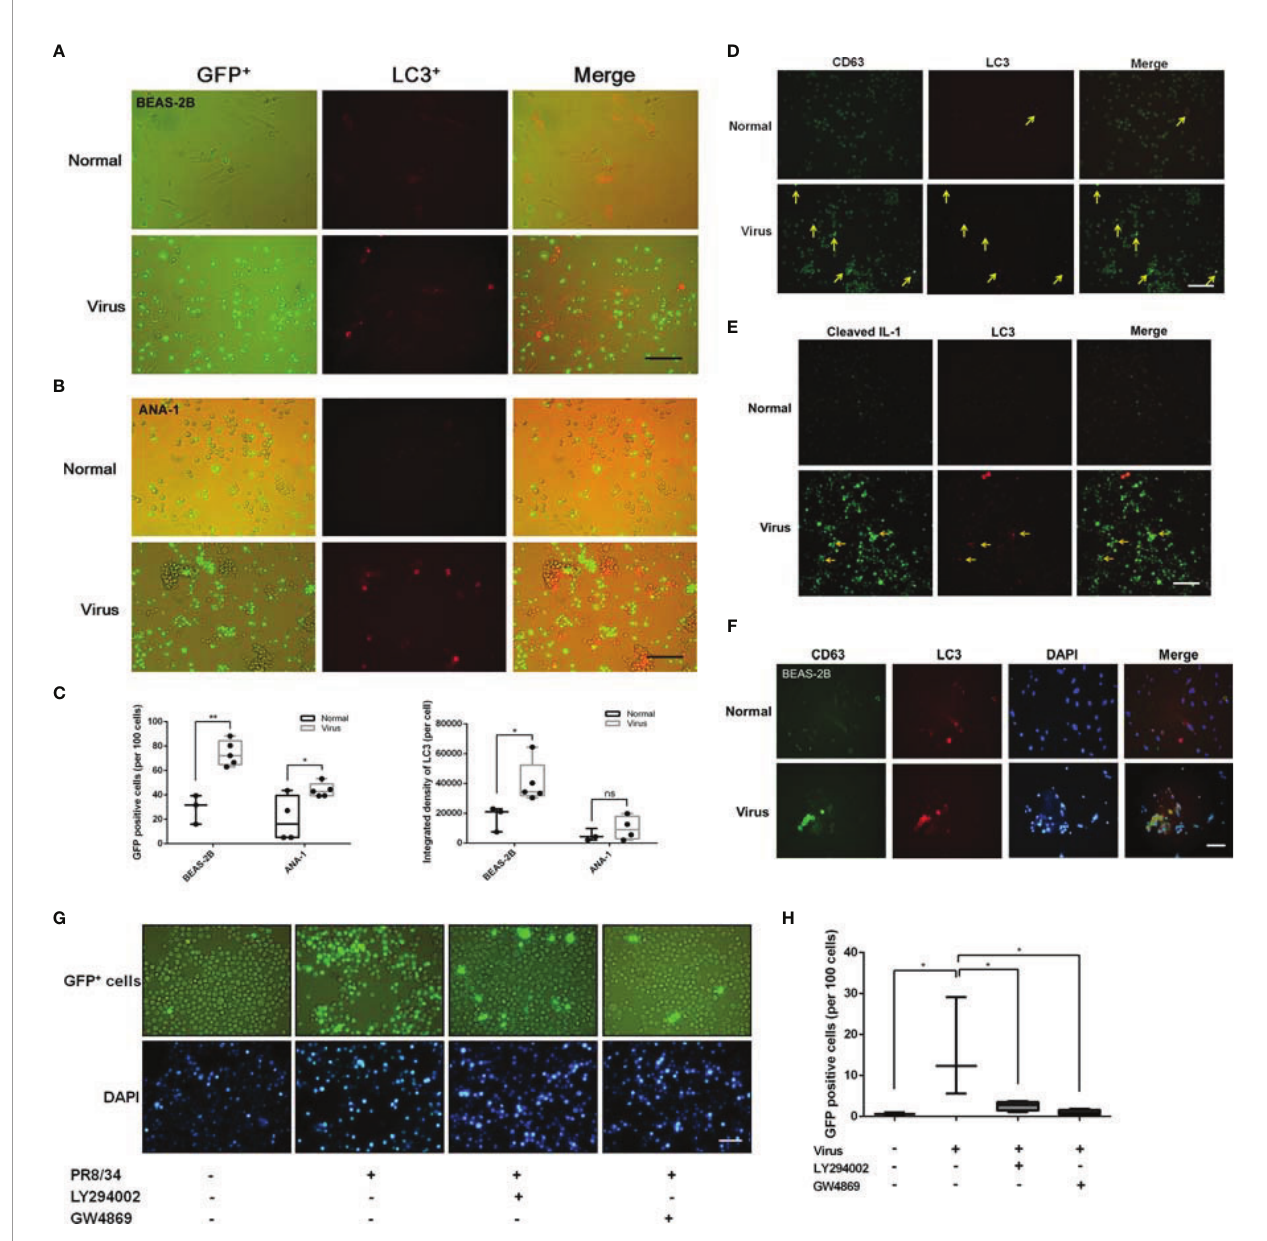
FIGURE 6 | Crosstalk among LC3, CD63, and cleaved IL-1 b in macrophage recruitment. (A, B) Transwell assays results showed that LC3 enhanced macrophage recruitment in PR/8/34 infected BEAS-2B cells (A) and ANA-1 cells (B) . GFP + ANA-1 cells were incubated in the upper chambers, BEAS-2B and ANA-1 cells transfected with mRFP-LC3 lentivirus were incubated in the lower chambers and infected with PR/8/34 virus. Scale bar: 100 m m. (C) Cell counting of GFP-positive cells (per 100 cells) and the fl uorescent quantitation of LC3 (per cell) using the Image-Pro Plus 6.0 software. No fewer than three fl uorescent images were captured and analyzed per group. * p < 0.05 and ** p < 0.01. (D, E) LC3, CD63, and IL-1 b interaction. The ANA-1 cells transfected with mRFP-LC3 lentivirus were infected with PR/8/34 virus for 24 h. Then, these cells were fi xed, permeabilized, blocked, probed with primary antibodies for the detection of CD63 (D) , and cleaved IL-1 b (E) , followed by exposure to the anti-rabbit IgG Fab2 Alexa Fluor ® 488 molecular probes. After staining the cell nuclei with DAPI, the interaction between LC3/ CD63/IL-1 b was observed and imaged. Scale bar: 100 m m. (F) LC3 and CD63 interaction in the infected BEAS-2B cells. The BEAS-2B cells transfected with mRFP- LC3 lentivirus were infected with PR/8/34 virus for 24 h. The cells were then fi xed, permeabilized, blocked, and probed with primary antibodies for the detection of CD63, followed by the anti-rabbit IgG Fab2 Alexa Fluor ® 488 molecular probes. After staining the cell nuclei with DAPI, the interaction of LC3/CD63 was observed and imaged. Scale bar: 50 m m. (G) The in fl uence of autophagy and exosome inhibitors on macrophage recruitment. GFP + ANA-1 cells were incubated in the upper chambers of the transwell system, while ANA-1 cells were incubated in the lower chambers, infected with PR/8/34 virus, and treated with the autophagy inhibitor LY294002 (1 µM) and the exosome inhibitor GW4869 (1 µM). GFP + ANA-1 macrophages in the lower chambers were counted to evaluate the trans-membrane recruitment of macrophages. Scale bar: 50 m m. (H) Cell counting of GFP-positive cells (per 100 cells). No fewer than three fl uorescent images were captured and analyzed per group. *p < 0.05. ns, no signi fi